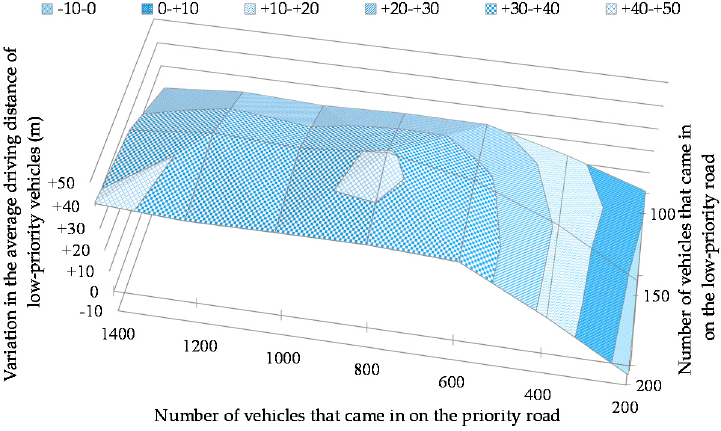
Figure 16. Variation in the average driving distance of low-priority vehicles that came in when the number of vehicles that came in was varied. The average driving distance was the average for the entire percentage range of self-driven vehicles.